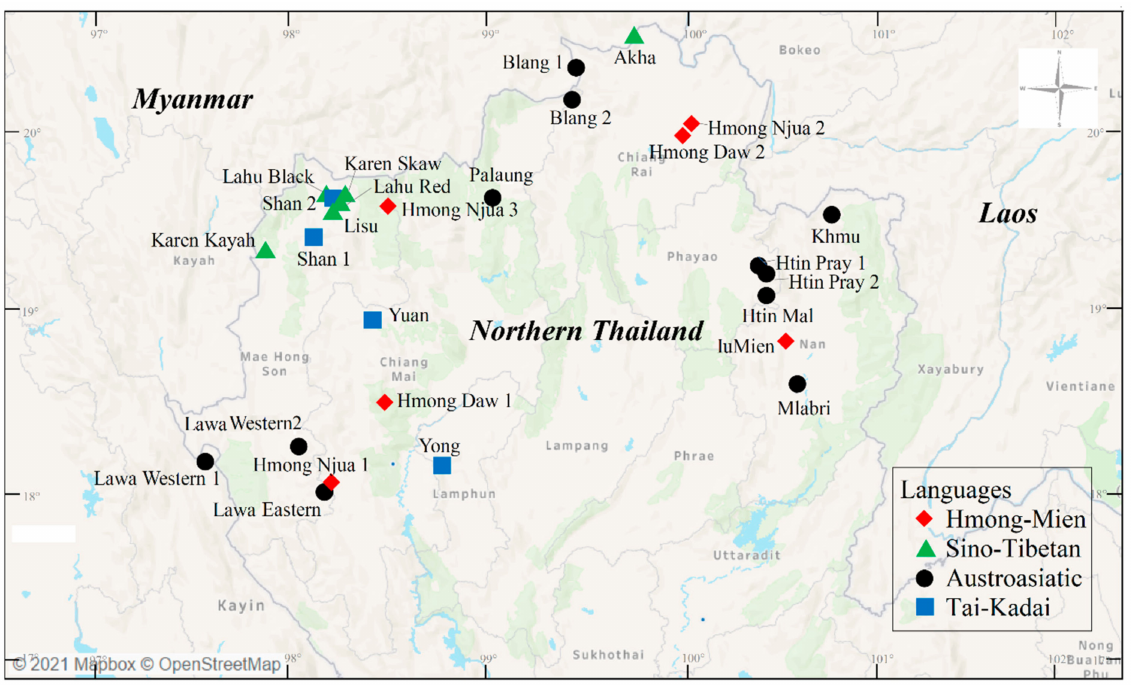
Figure 1. Map of sampling locations. There are 21 populations sampled in present study, together with 6 populations in previous studies. Red diamonds, green triangles, black circles, and blue squares represent Hmong-Mien (HM)-, Sino-Tibetan (ST)-, Austroasiatic (AA)- and Tai-Kadai (TK)-speaking populations,